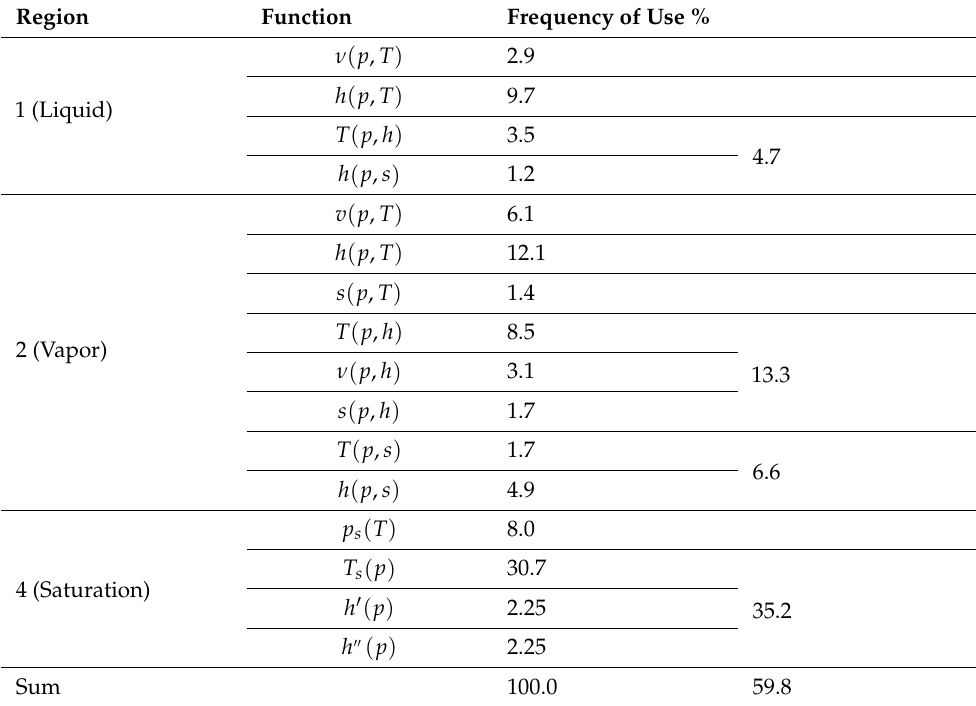
Table 1. Most important property functions and their frequency of use [23].